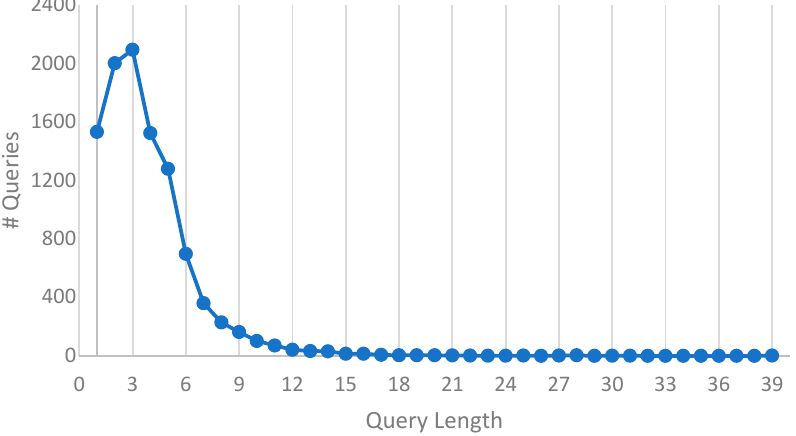
Figure 1. Frequency distribution of web queries with respect to query length. No. of queries are on the Y-axis and query length is on the X-axis.